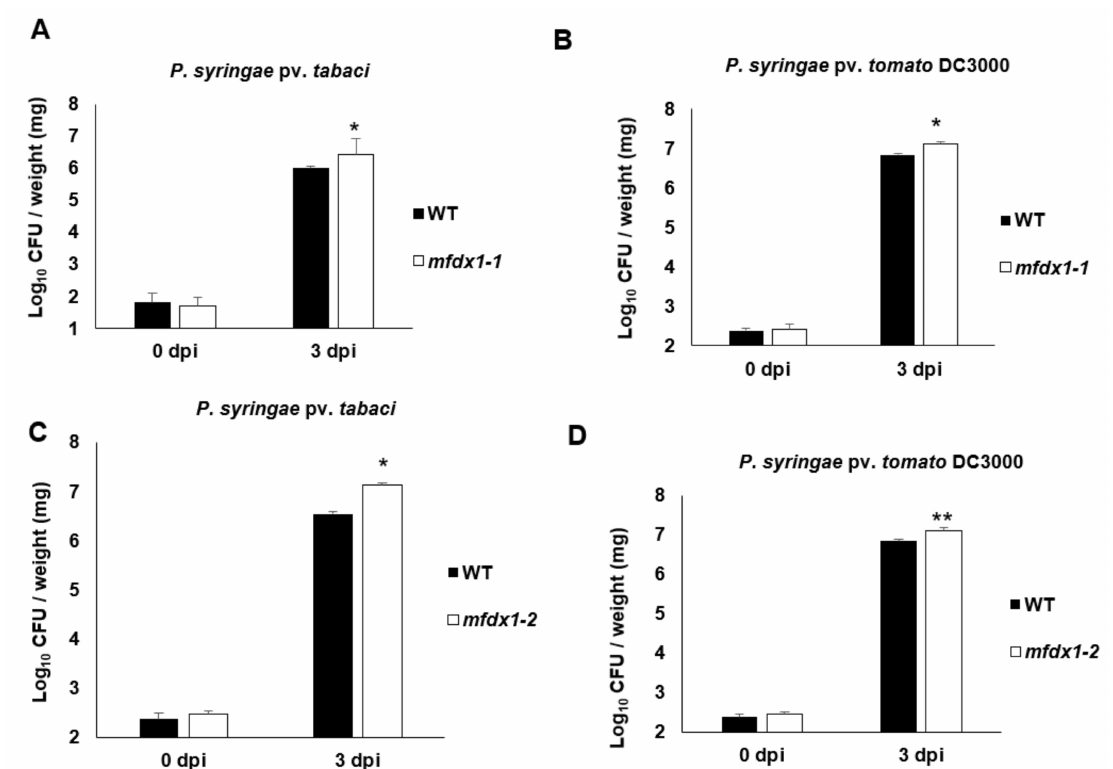
Figure 2. The Arabidopsis mfdx1 mutants are more susceptible to host and nonhost pathogen infection: ( A , B ) Quantification of host and nonhost pathogen multiplication in the mfdx1-1 mutant. Three-week-old WT (Col-0) and mfdx1-1 mutant plants were flood inoculated with nonhost pathogen P. syringae pv. tabaci at 1.6 × 10 6 colony forming units (CFU)/mL ( A ) or host pathogen P. syringae pv. tomato DC3000 at 8 × 10 4 CFU/mL ( B ). Samples (rosettes) were collected at 0 dpi and 3 dpi for bacterial quantification. Histograms represent means of four biological replicates. Error bars indicate standard error. Asterisks indicate a significant difference according to Student’s t test (* p -value < 0.05). All experiments were repeated two times with similar results. ( C , D ) Quantification of host and nonhost pathogen multiplication in the mfdx1-2 mutant. Three-week-old WT and mfdx1-2 mutant plants were flood inoculated with nonhost pathogen P. syringae pv. tabaci at 1.6 × 10 4 colony forming units (CFU)/mL ( C ) or host pathogen P. syringae pv. tomato DC3000 at 8 × 10 4 CFU/mL ( D ). Samples (rosettes) were collected at 0 dpi and 3 dpi for bacterial quantification. Histograms represent means of four biological replicates. Error bars indicate standard error. Asterisks indicate a significant difference according to Student’s t -test (* p -value < 0.05 and ** p < 0.01). All experiments were repeated two times with similar